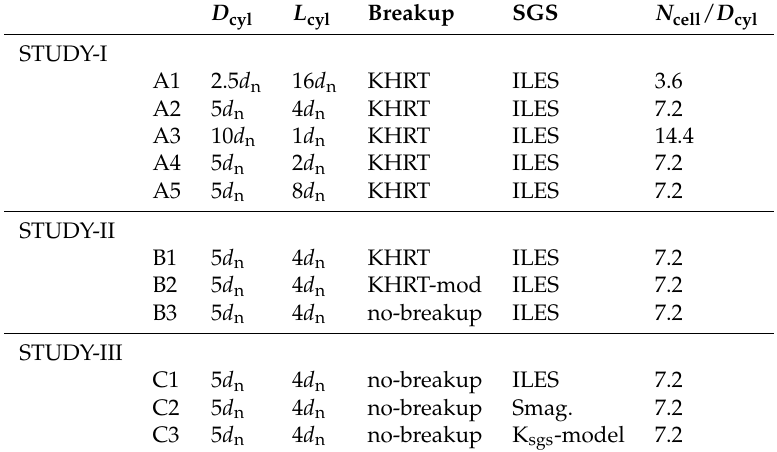
Table 3. Summary of the large-eddy simulation (LES) test cases considered in the present work. Study-I investigates the cylindrical injection volume. Study-II investigates the droplets secondary breakup and assess the no-breakup model. Study-III investigates subgrid scale (SGS) models when no-breakup model is used. Most right column states the radial amount of cells within D cyl